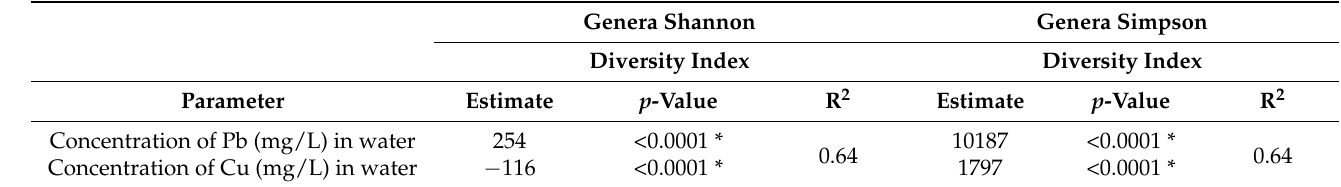
Table 3. Multiple regression model with estimate (slope), p -value (significance), and combined R 2 of the relationship between Shannon and Simpson diversity indices of genera and the concentration of Pb and Cu added (mg/L) to the water of metal microcosms. * in the p -value column indicates a strong probability of significance.